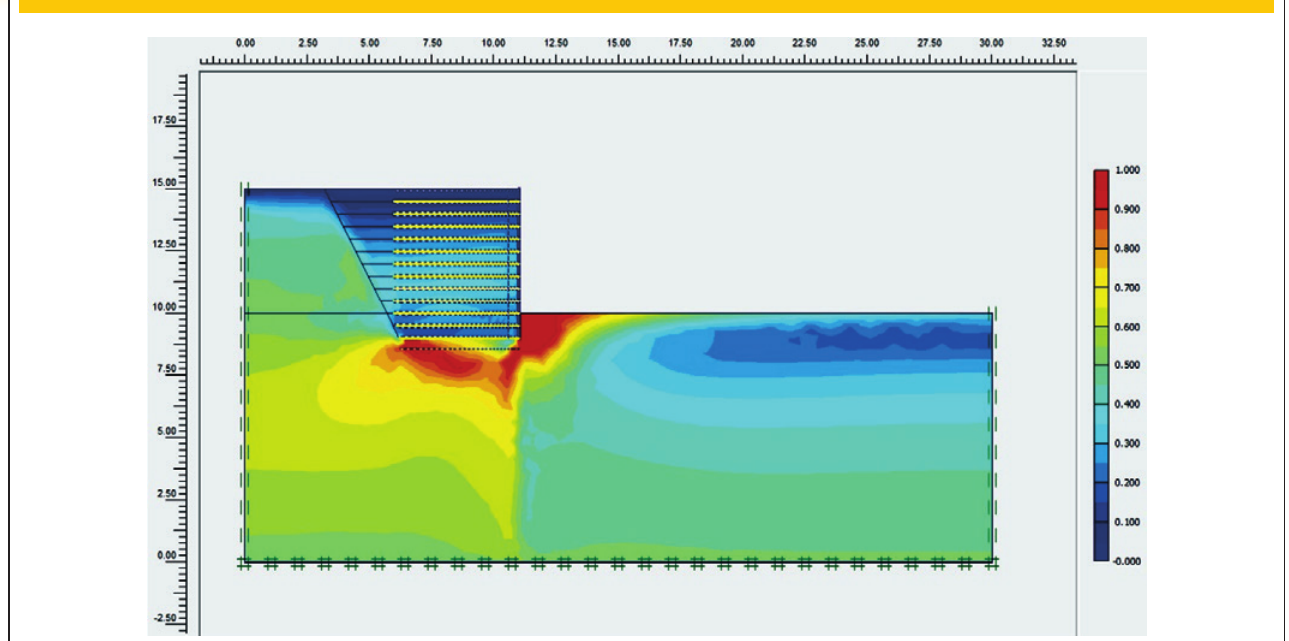
Figure 14 – Effective relative stresses (S90/10